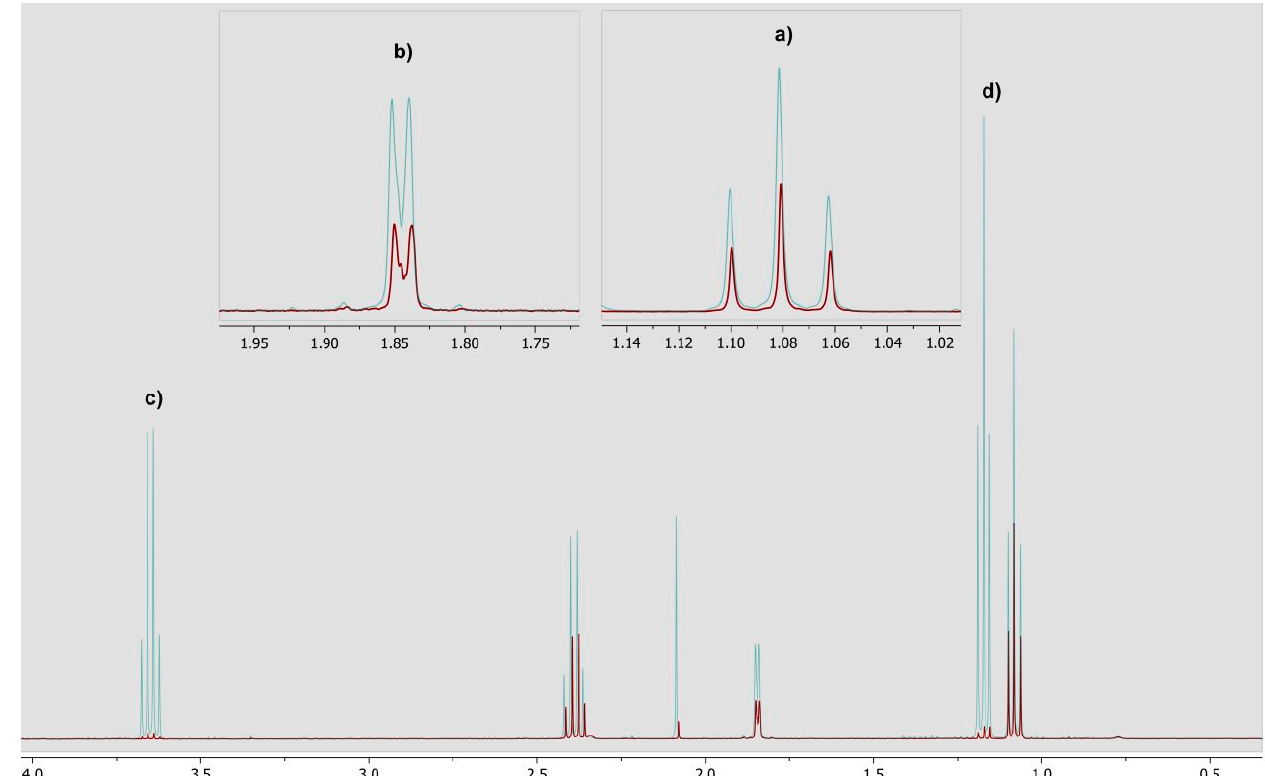
Figure 2. Representative 1 H NMR spectra of target additives in yufka bread sample: ( a ) propionic acid; ( b ) sorbic acid ( c ) ethanol–CH 2 ; ( d ) ethanol–CH 3 ( x -axis: ppm, y -axis arbitrary units). Table 6. Propionic acid and sorbic acid concentration expressed in mg/kg in all analyzed samples (n.d. not detectable (propionic acid: < 94 mg/kg; sorbic acid: < 258 mg/kg). Concentration (mg/kg) Yufka, Pasta Rye-Bread, Partially Baked, Prepacked Bakery Wares Bread, Not Prepackaged ( n = 2) ( n = 21) ( n = 76) Sorbic Acid Propionic Acid Sorbic Acid Propionic Acid